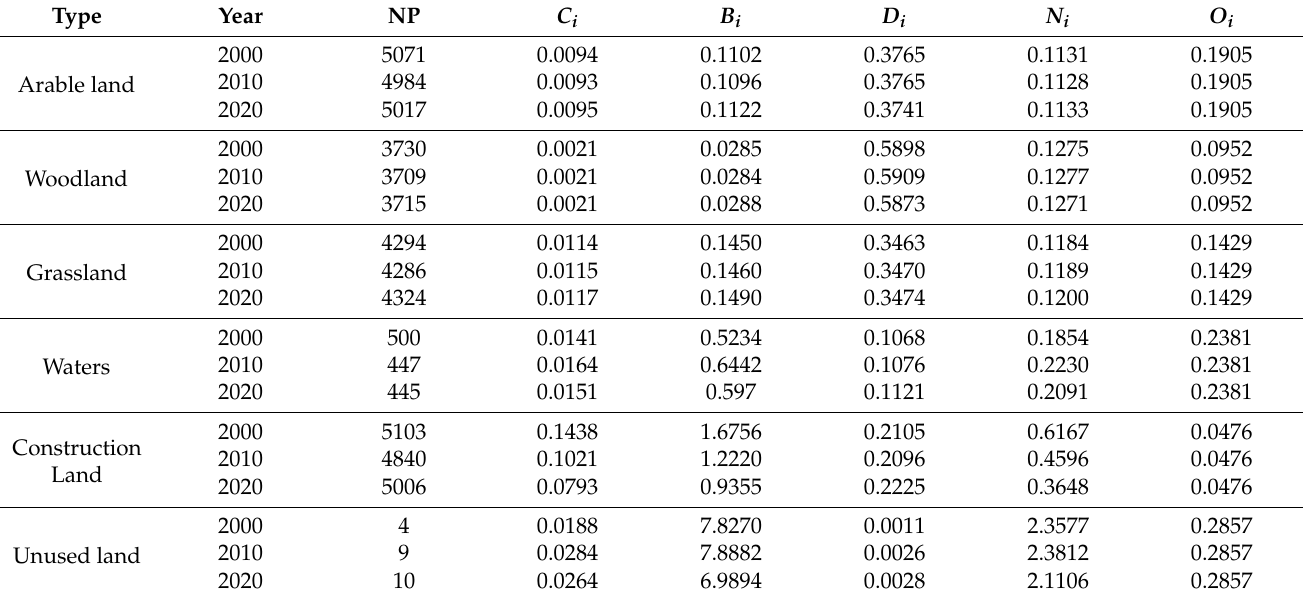
Table 5. The landscape pattern indices of each land-use type in Guilin from 2000 to